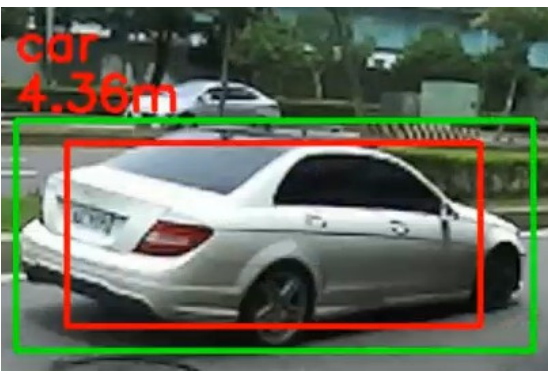
Figure 10. The cropped box of object detection.